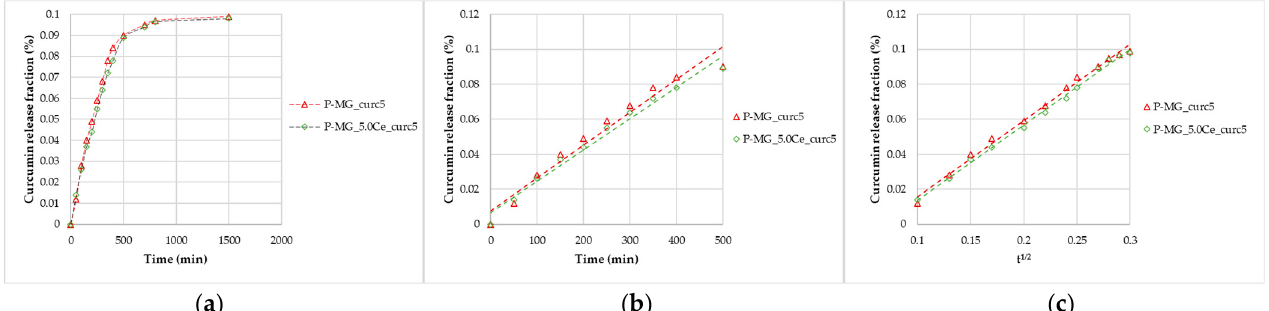
Figure 5. Curcumin release kinetics from P-MGs; ( a ) graph of the curcumin fraction released in the first 24 h compared with the amount contained in 50 mg; ( b ) linearization according to Peppas’ model (n = 1); and ( c ) linearization according to Higuchi’s model.